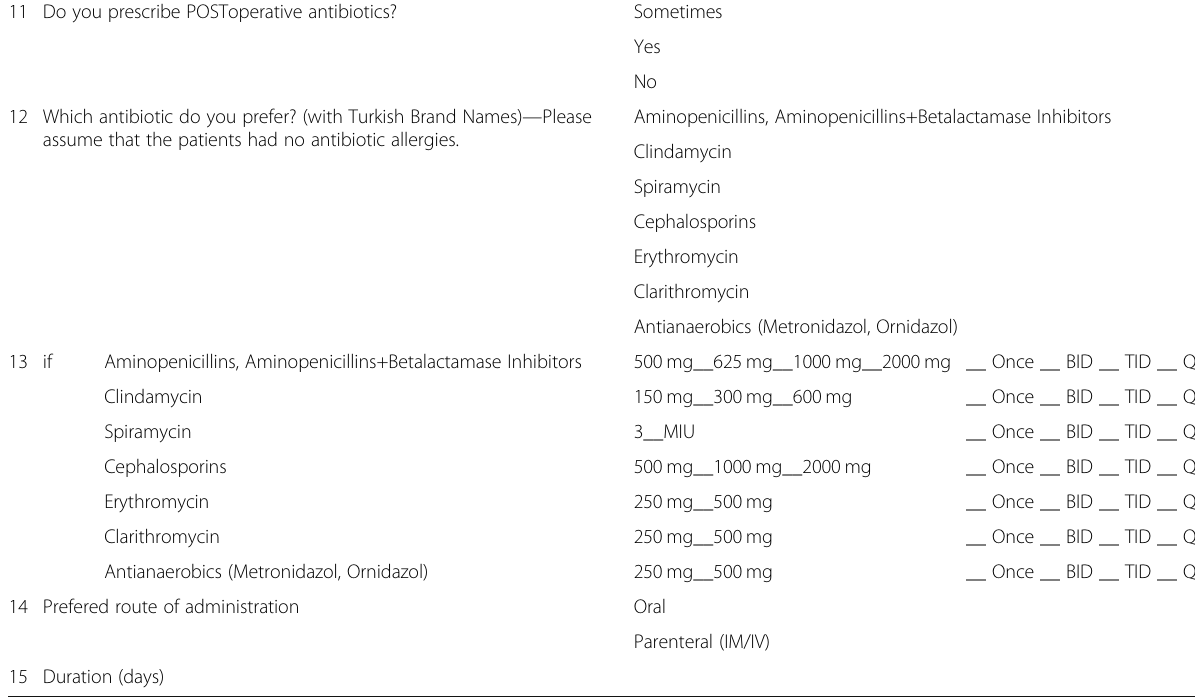
Table 3 Questions about POSToperative antibiotic prescription habits of the clinicians 11 Do you prescribe POSToperative antibiotics?